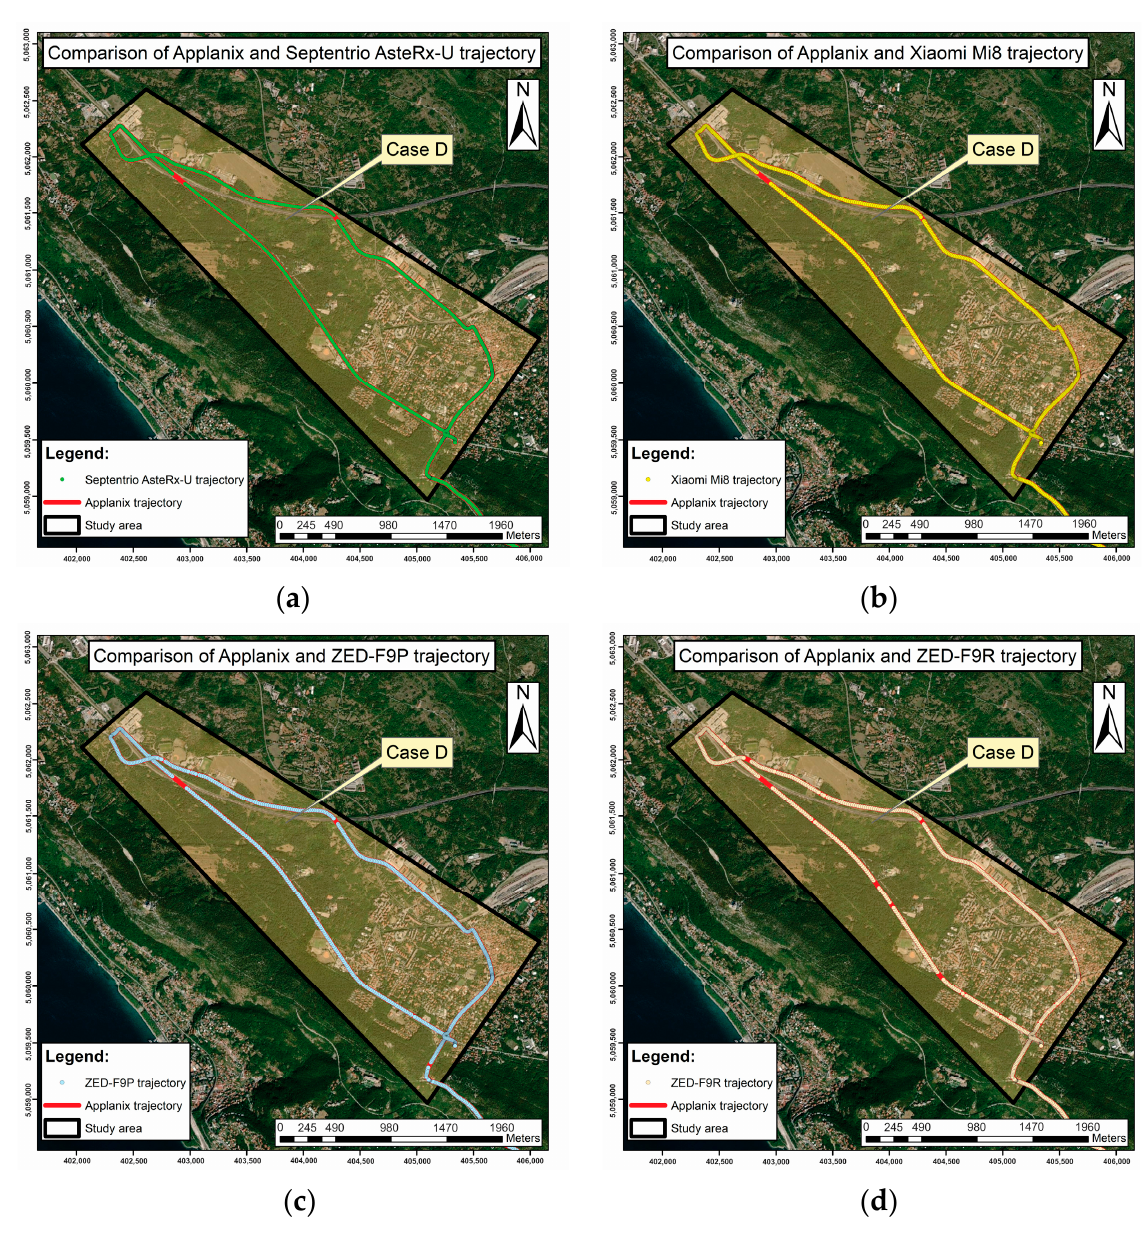
Figure 15. Case D: performance of: ( a ) Septentrio AsteRx-U, ( b ) Xiaomi Mi8, ( c ) u-blox ZED-F9P, and ( d ) u-blox ZED-F9R. Table 13. GPS solutions, solutions with fixed ambiguities, and deviation of distances below the given threshold. Situation Case D—open sky conditions with vegetation by the roadside (no. of total: 1001).